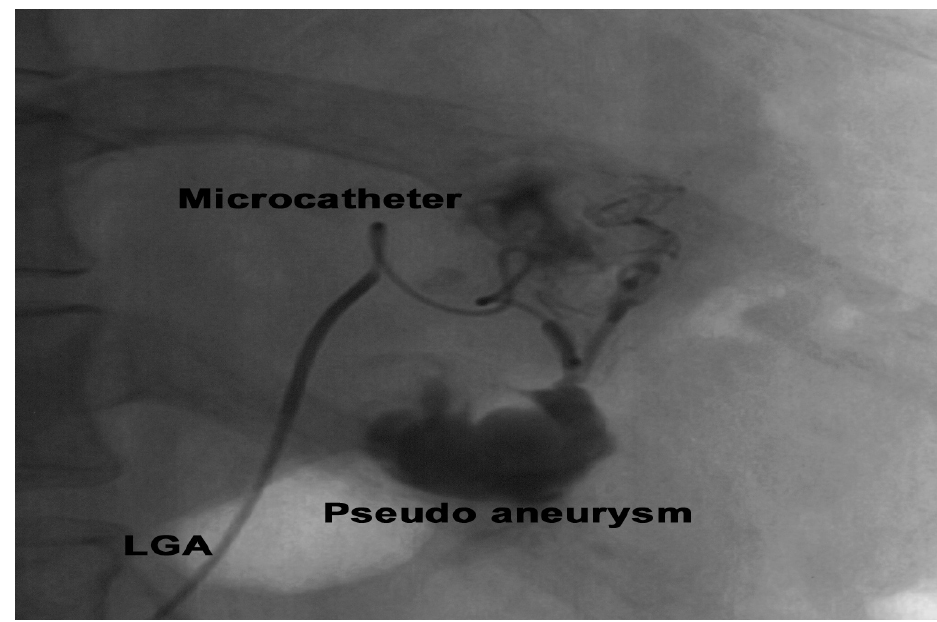
FIGURE 4 . Completion celiac axis angiography demonstrates successful occlusion of the